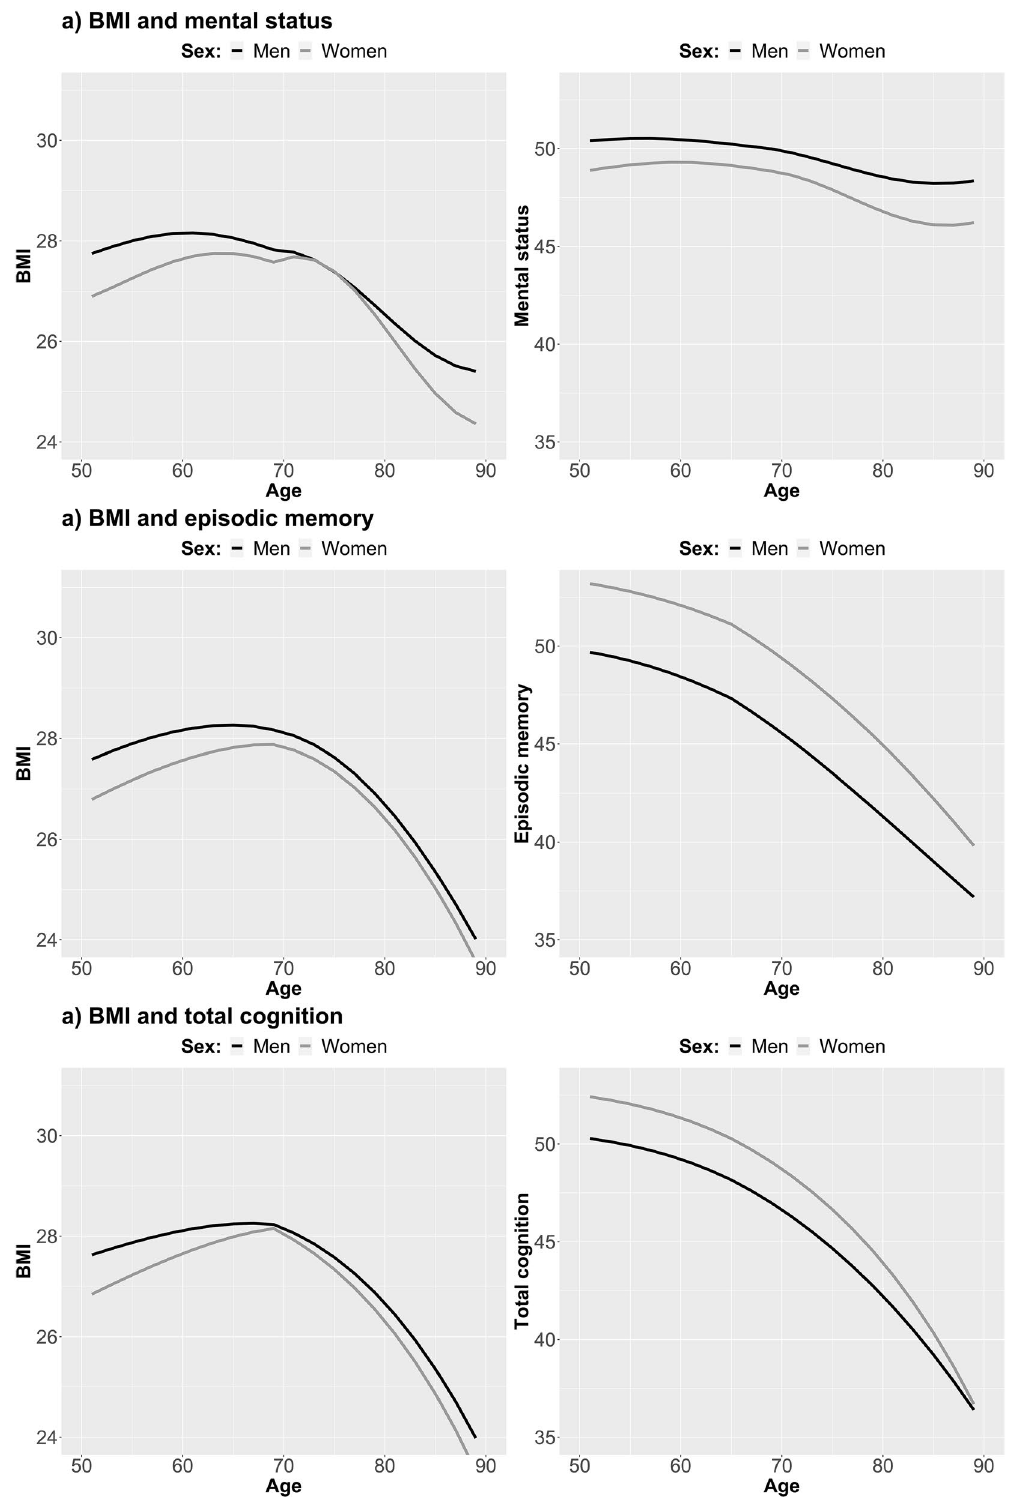
Figure 4. Longitudinal trajectories from bivariate dual change score models, showing change in BMI and cognitive abilities for men and women separately. Models were adjusted for education, and a breakpoint in the proportional change and coupling parameters added at age 70 for BMI and mental status, and at 65 for episodic memory and total